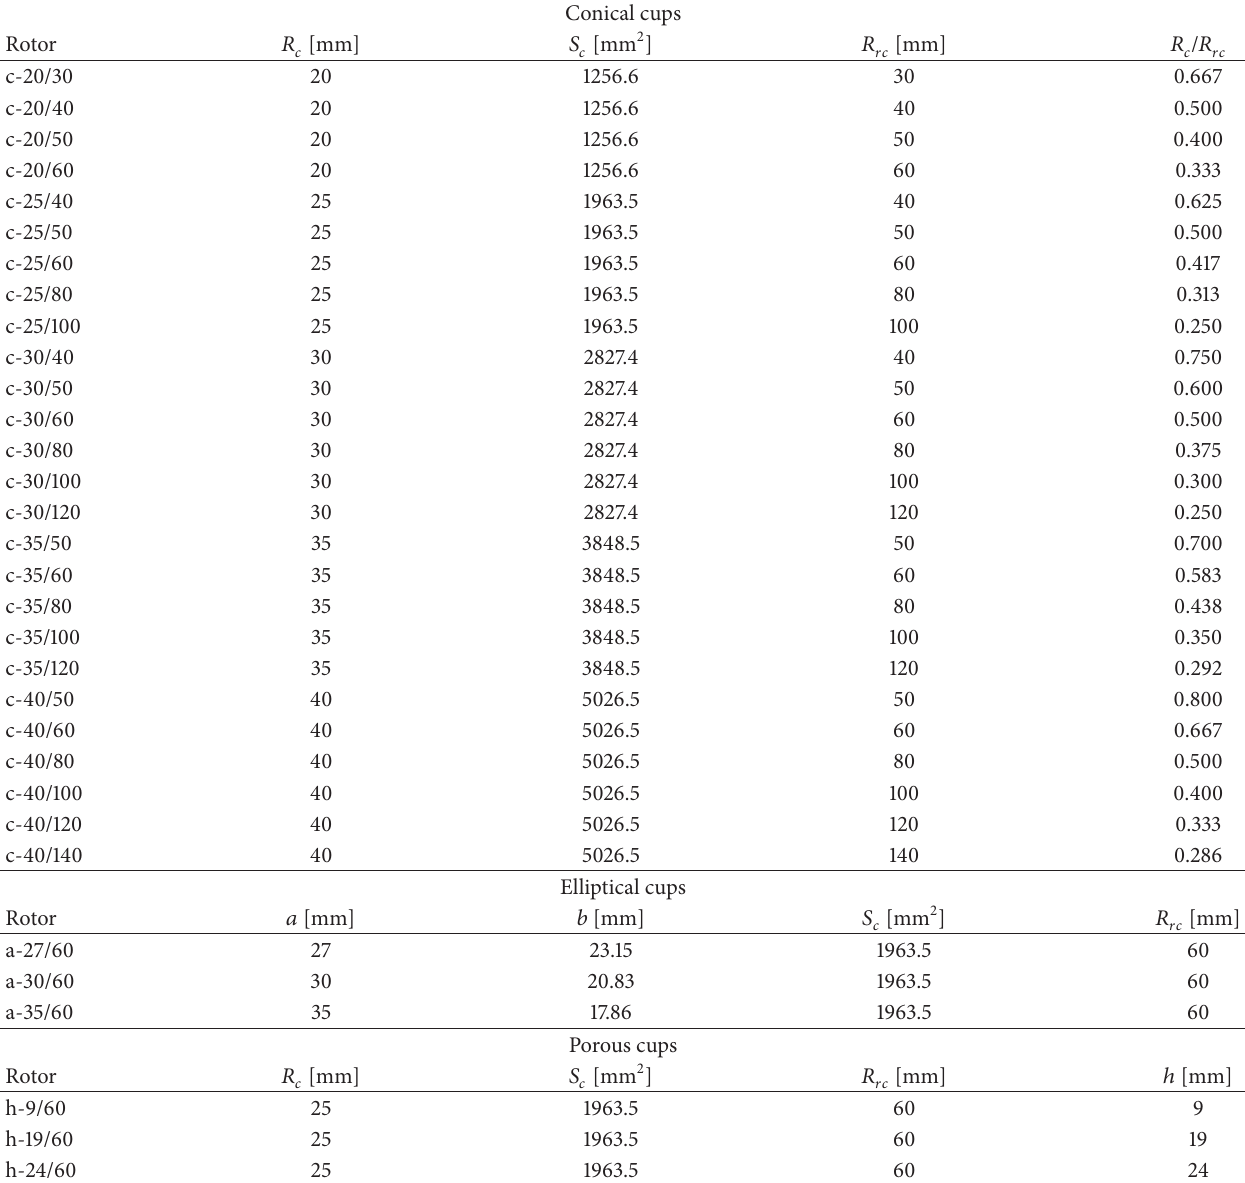
Table 2: Geometrical characteristics of the rotors tested: cup center rotation radius, 𝑅 𝑟𝑐 , front area of the cups, 𝑆 𝑐 , cup radius (conical and porous cups), 𝑅 𝑐 , ratio of cup radius to the cups’ center rotation radius (conical cups), 𝑅 𝑐 / 𝑅 𝑟𝑐 , hole diameter of porous cups, ℎ , and semi-major and semi-minor axes, 𝑎 and 𝑏 , of elliptical cups. See also Figure